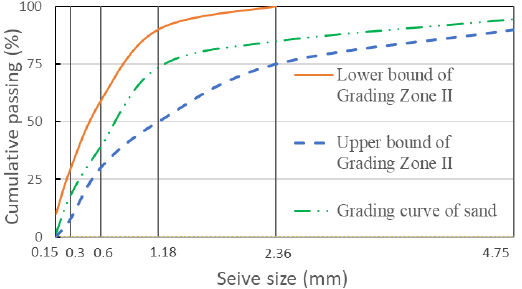
Figure 1. Grading curve of the sand used in the experiments. Three groups of specimens, i.e., cement paste, mortar, and concrete, were fabricated with three w/cs of 0.4, 0.5, and 0.6 for each group. Table 1 shows the mixture proportions and the number of specimens used for different purpose. All specimens had a prismatic shape, but the dimensions were 70.7 mm × 70.7 mm × 230 mm for the cement paste speci- mens and mortar specimens and 100 mm × 100 mm × 300 mm for the concrete specimens. This difference was due to the consideration of different aggregate sizes in the mortar and concrete specimens. The specimens were cured for 28 days as standard before the follow- ing steps were carried out. Table 1. Mixture proportions and number of specimens. Type